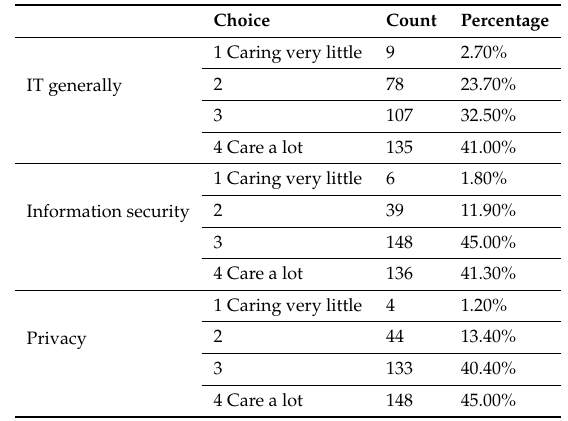
Figure 4. Comparison of self-reported IT skill, in %, for the different questionnaires N = 329. 1 was very little skilled, and 4 was highly skilled in IT. Table 7. Comparison of self reported interest in IT in general, information security and privacy. The data are presented with the number of answers for each option and the percentage for the answer N = 329. 1 was caring very little, and 4 was caring a lot.